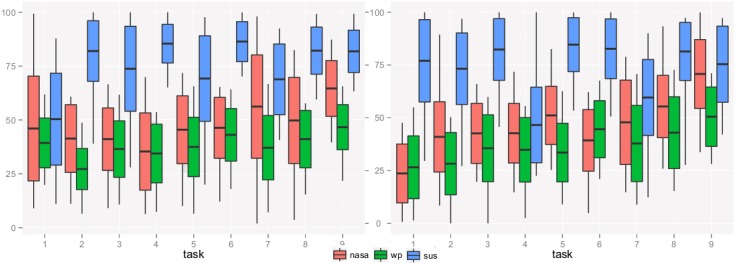
Summary statistics by task.